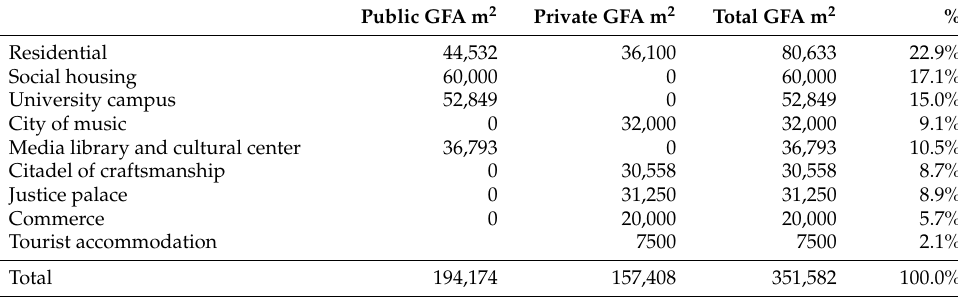
Table 5. Hypothesis of distribution of the functional